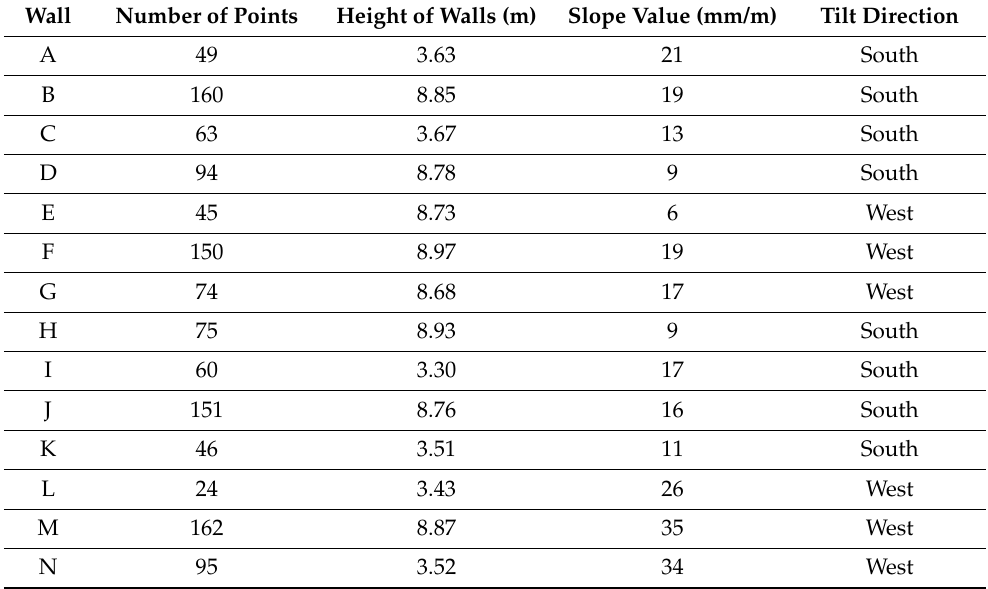
Table 2. The value of the wall deviation from the vertical (wall markings in accordance with Figure 10). Wall Number of Points Height of Walls (m) Slope Value (mm/m) Tilt Direction A 49